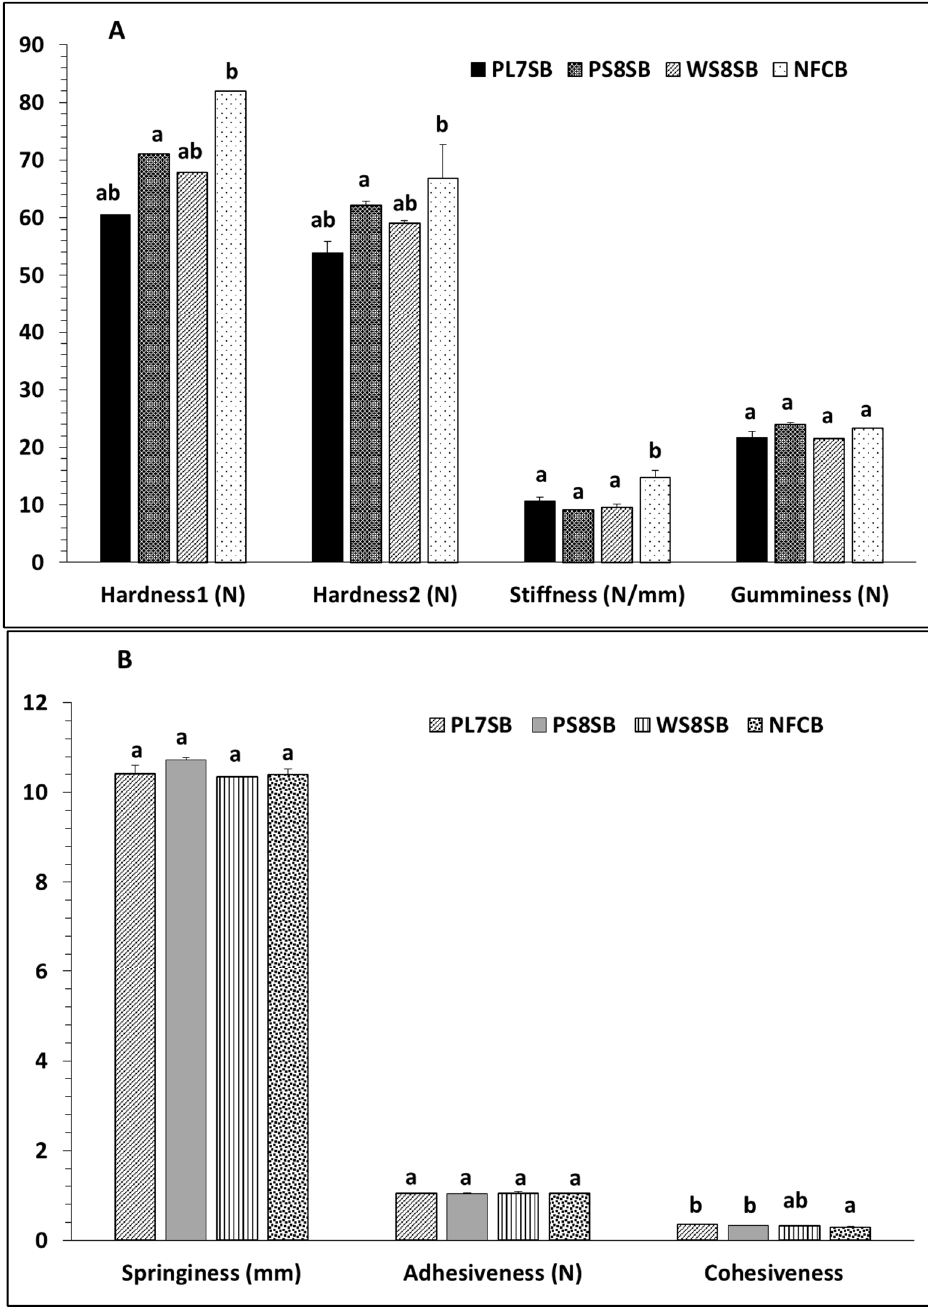
Figure 2. Texture Parameters of sourdough breads (SB) obtained with different LAB strains and control bread. ( A ) Hardness 1, Hardness 2, Stiffness and Gumminess; ( B ) Springiness, Adhesiveness and Cohesiveness. Results indicate mean values; error bars indicate standard errors. Different letters (a, b) represent significant differences ( p value < 0.05) by Tukey’s test. PL7SB (SB with Pediococcus pentosaceus LD7); PS8SB (SB with Pediococcus pentosaceus SA8); WS8SB (SB with Weissella confusa SD8), NFCB (control bread without